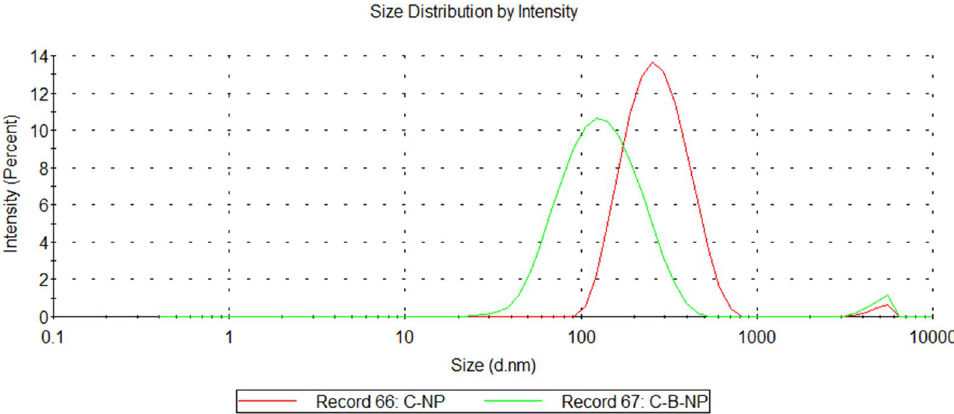
Figure 1. C-NP and C-B-NP intensity size distribution by dynamic light scattering. Result is presented as average data from three measurements and created by authors using Zetasizer software (version 8.01.4906, Malvern